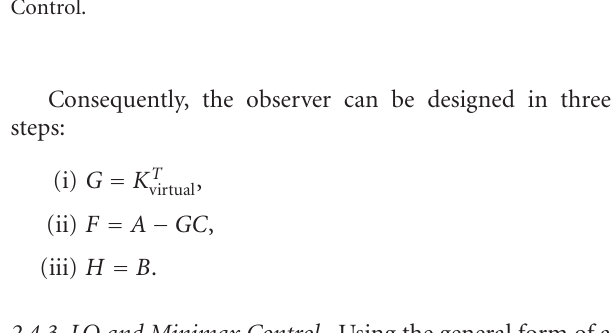
Figure 4: Closed-loop simulation results in case of Pole-Placement